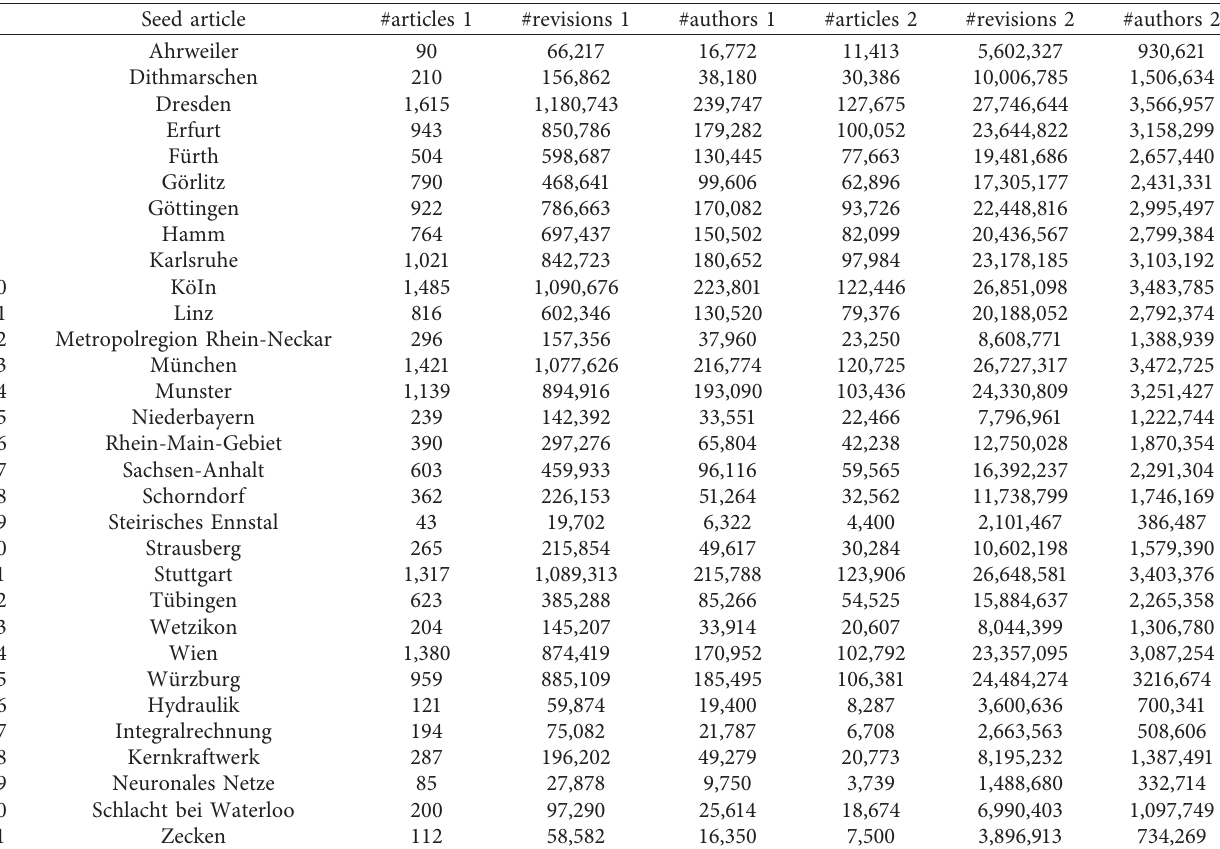
Table 3: Wikipedia-based corpora: number of content articles (#articles n ), revisions (#revisions n ), and authors (#authors n ) of non- redirecting articles in WP-R EGIO -1 ( n � 1) and WP-R EGIO -2 ( n � 2) of the German Wikipedia dump from 201807-01 (subgraphs 1–25); the variable n codes the n th orbit (see formula (30)). Subgraphs 26–31 are used to generate the corpora WP-O THERS -1 and WP-O THERS -2.